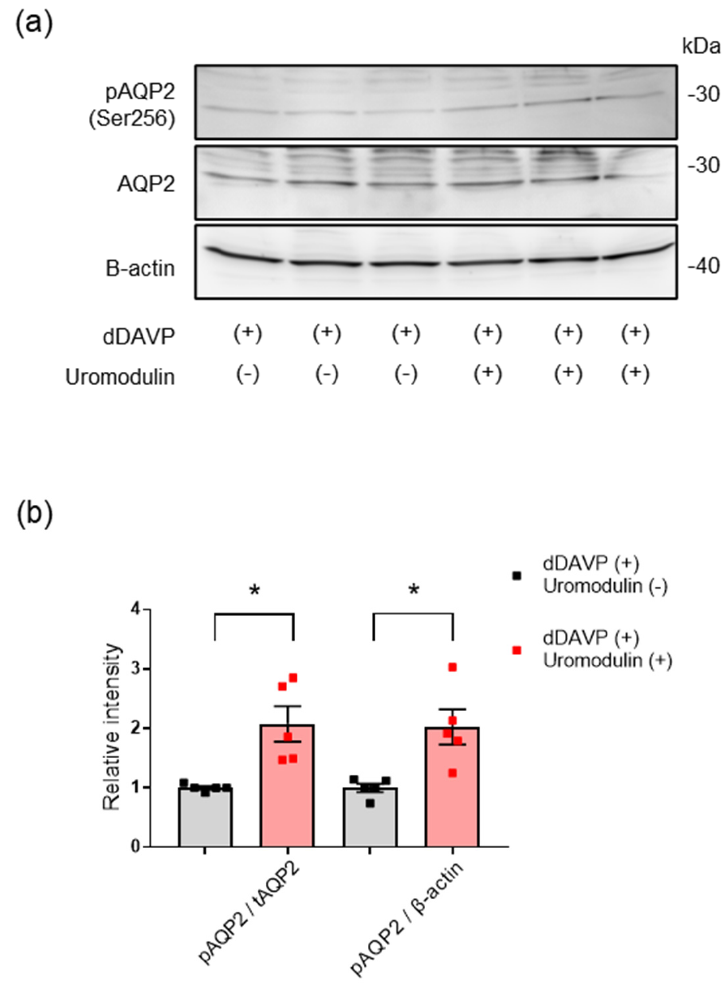
Figure 6. Effect of uromodulin on AQP2 activation. ( a ) Western blot analysis for Ser256- phosphorylated AQP2 and total AQP2 in lysates of mouse collecting duct cells. Cell monolayer on a filter membrane was treated with 10 − 9 M dDAVP on the basolateral side and 10 − 6 µg/mL uromodulin on the apical side for 24 h. β -actin was used as a loading control. ( b ) Quantification of the signal intensities expressed as a ratio of phosphorylated AQP2 to total AQP2. Analyses were based on at least three independent experiments. * p < 0.05 (Unpaired t -test).